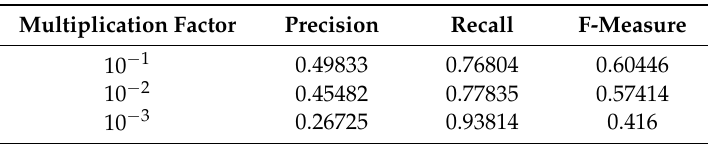
Table 2. Variation results of the alpha and n values in the evaluation of the plagiarism detection system using the learning vector quantization